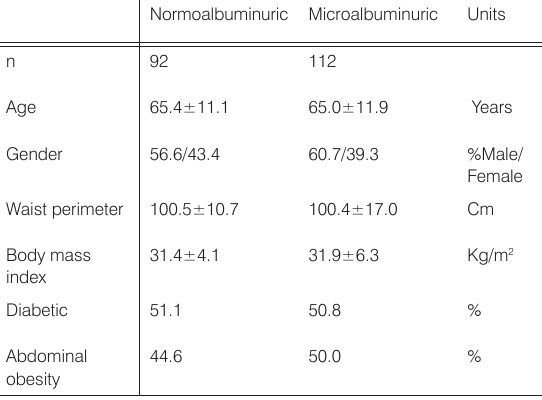
Table 1. Comparative data at baseline. Differences are not signifi -